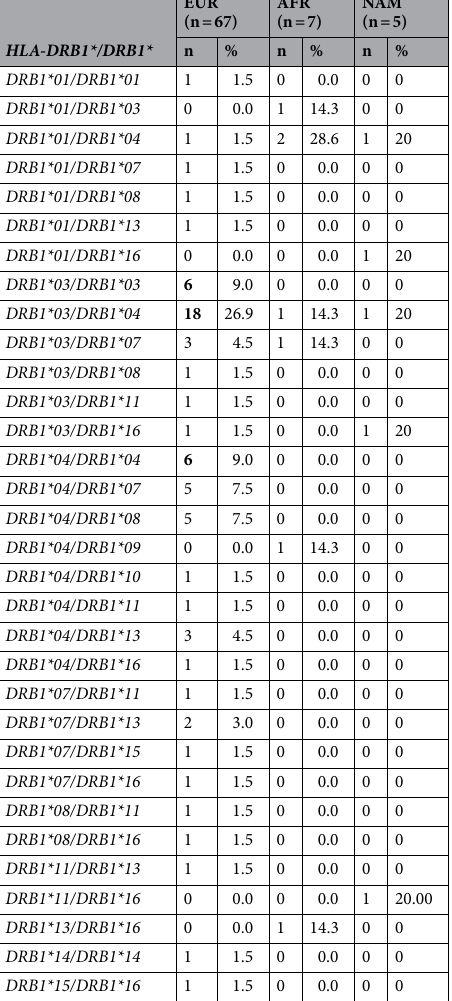
Table 6. Distribution of the HLA-DRB1*/DRB1* genotypes in patients with T1D according to Y chromosome category. Bold values indicate the most prevalent genotypes. EUR European Y chromosome, AFR African Y chromosome, NAM Native American Y chromosome. Chi-square test ( P =